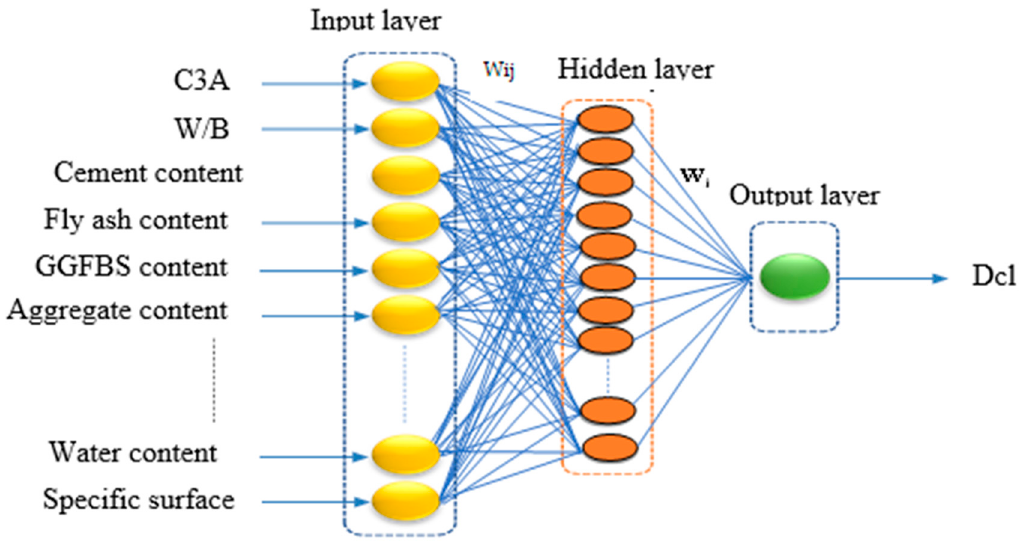
Figure 4. Structure of the ANN model.